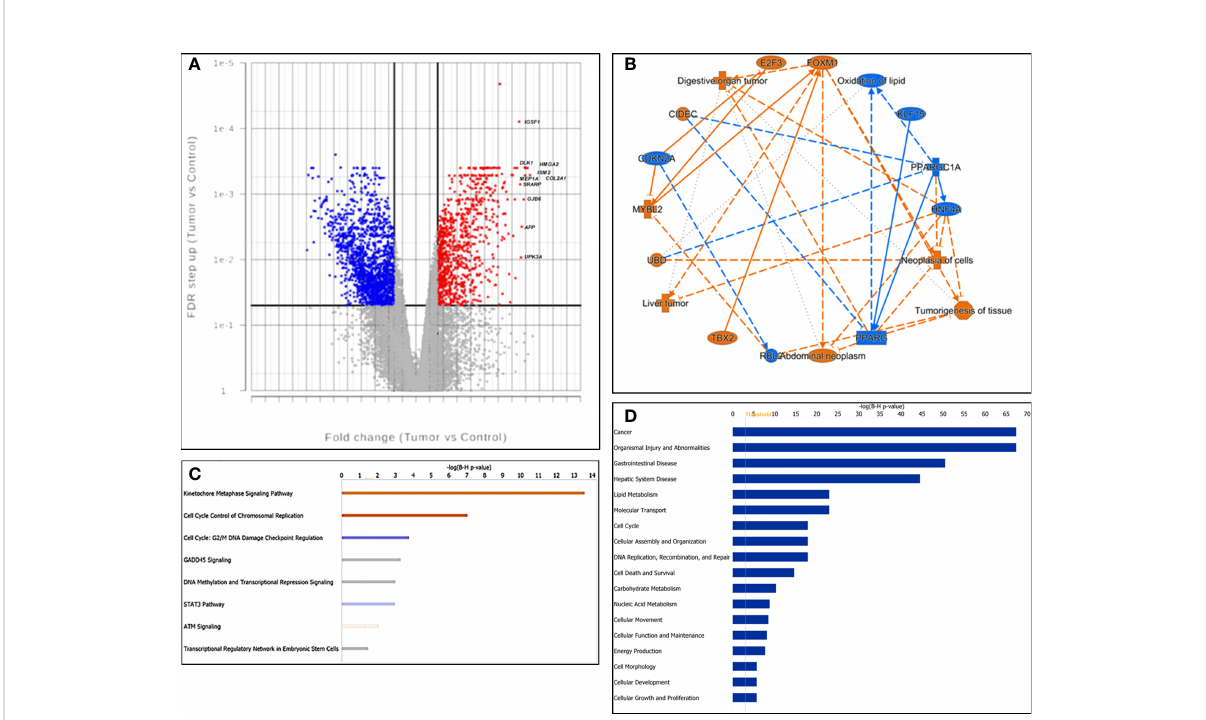
FIGURE 1 Characterization of gene expression pro fi ling. (A) Volcano plot of gene expression. X-axis: fold change difference; y-axis: FDR (false discovery rate); vertical lines: fold change >|3|; horizontal line: the signi fi cance cutoff (FDR p-value = 0.05). The 10 most upregulated genes were labeled. (B) The graphic summary, a network of interconnected biological fi ndings by IPA analysis. Predicted activation was labeled in orange, while predicted inhibition was labeled in blue. (C) Canonical signaling pathways enriched by differentially expressed genes. Z-scores were presented by colors. Red: activation; blue: suppression; gray: unable to make a con fi dent prediction; and white: unable to make a prediction. (D) The barchart displayed the most signi fi cantly enriched diseases and functions across the dataset, listed from the most signi fi cant to the